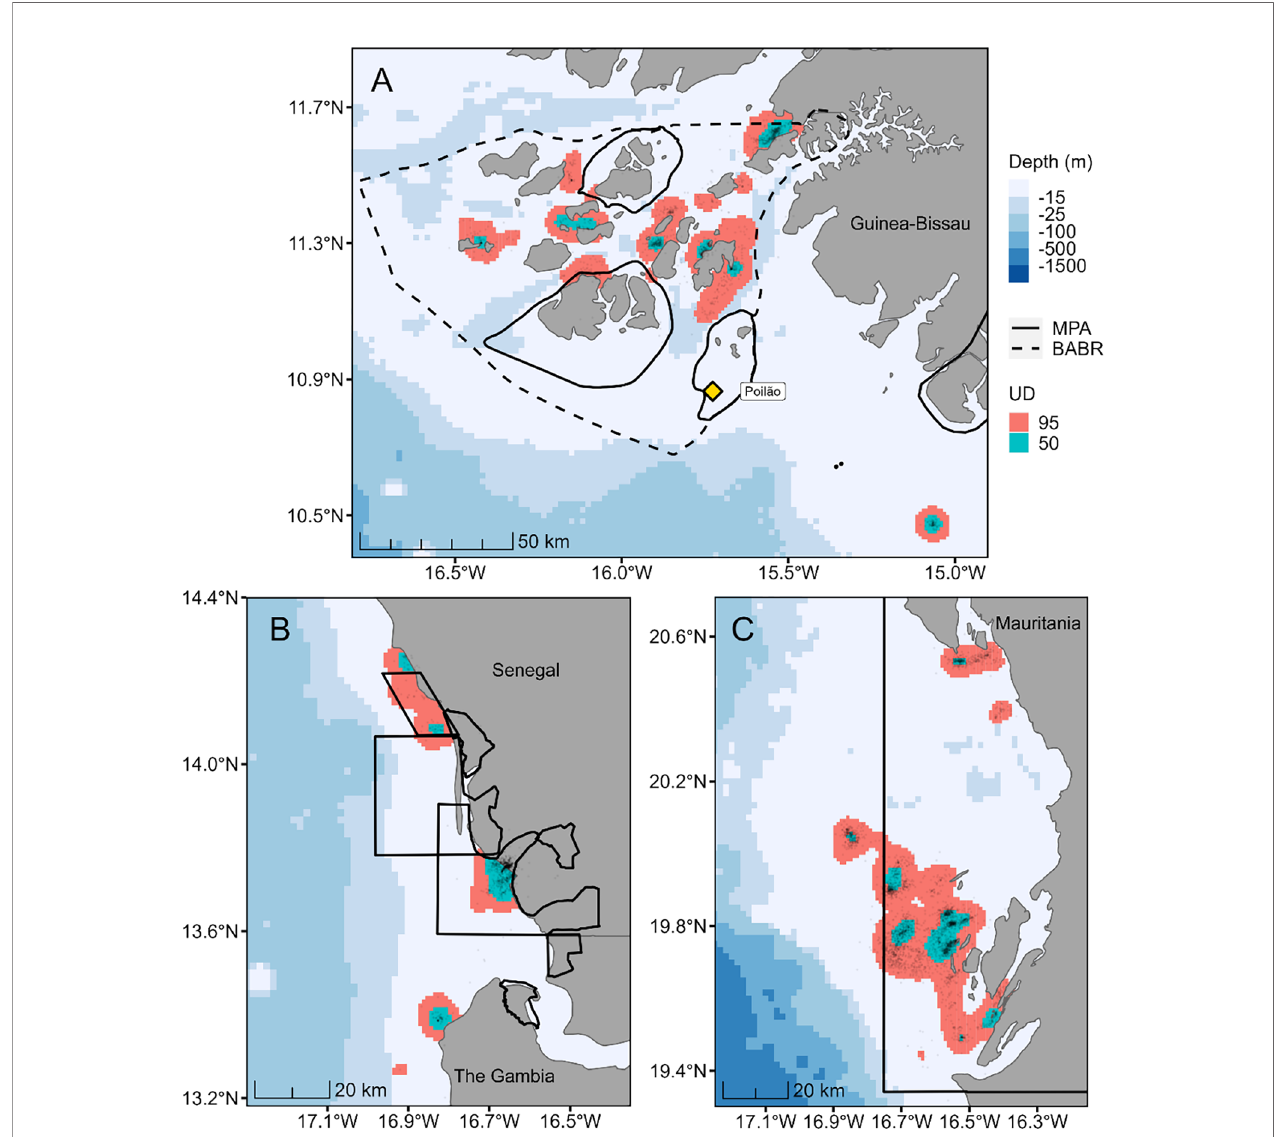
FIGURE 4 | Distribution of 35 female green turtles ( Chelonia mydas ) tracked during the post-nesting foraging period in (A) the Bijago ́ s Archipelago of Guinea-Bissau and south of the Bijago ́ s (n = 12), (B) the Saloum and Gambia river deltas of Senegal and The Gambia (n = 10) and (C) the Bay of Arguin in Mauritania (n = 13). Black dots represent tracking locations, and the underlying colored areas represent the 95% (pink) and 50% (blue-green) utilization distribution areas, respectively signifying the population-level home range and core-use areas during foraging. The bold solid lines indicate the location of existing marine protected areas (MPAs) and the dashed line shows the extent of the BABR biosphere